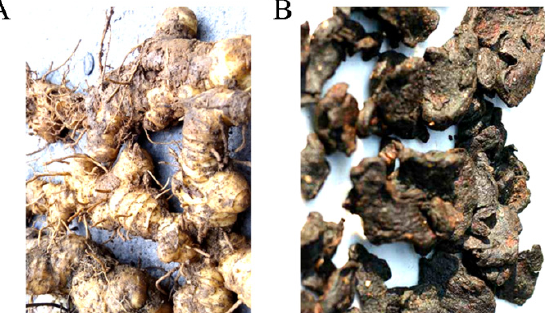
Figure 1. The traditional Chinese medicine Polygonati Rhizoma: ( A ) rhizome; ( B ) Polygonati Rhizoma.